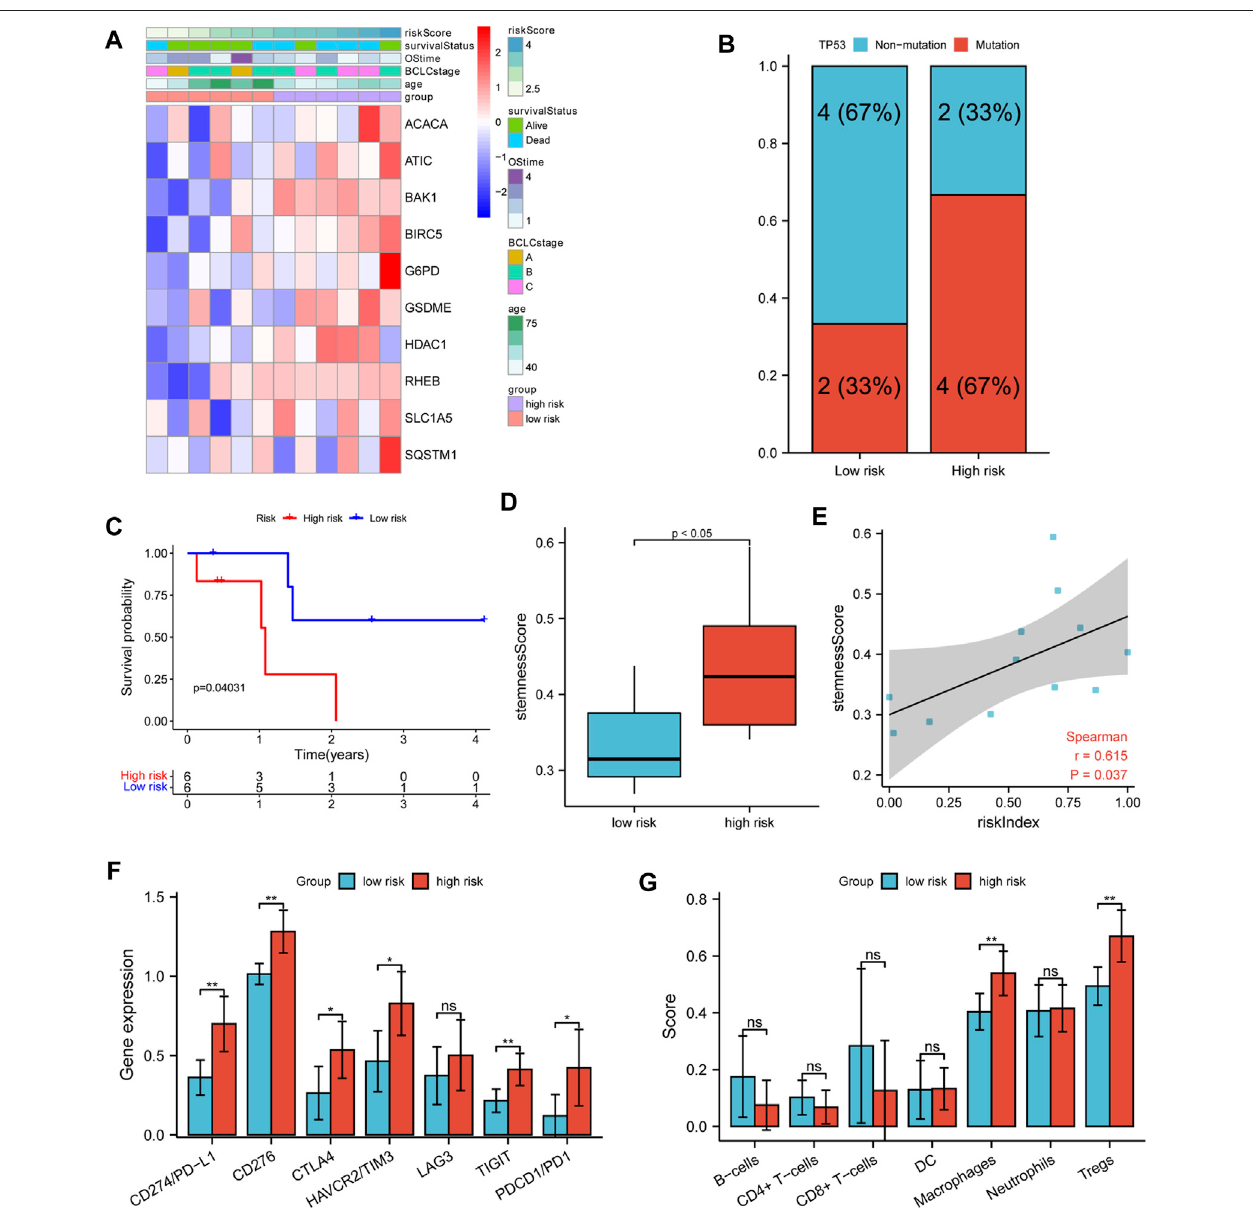
FIGURE 8 | Verifying analysis in our cohort. (A) The heatmap of clinicopathological features and 10 model-gene expressions in two risk subgroups. (B) The TP53 mutationrateindifferentrisksubgroups. (C) K – McurvesforOSofpatients. (D) Thestemnessscoreindifferentrisksubgroups. (E) Spearman ’ srankcorrelationanalysis between RI and stemness score. (F) The comparison expression of CTLA-4, LAG-3, PD-1, TIGIT, TIM-3, CD276, and PD-L1 between the high- and low-risk group. (G) The immune in fi ltration cell in different risk groups.